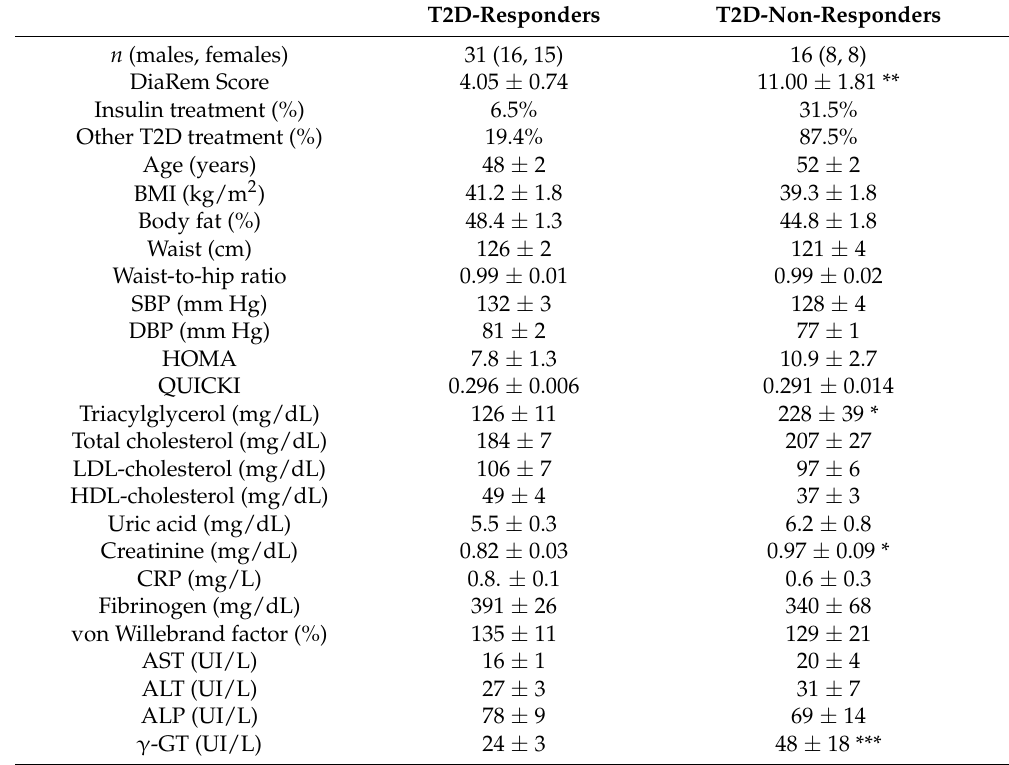
Table 3. Anthropometric and biochemical characteristics of obese patients with T2D classified as responders and non-responders one year after